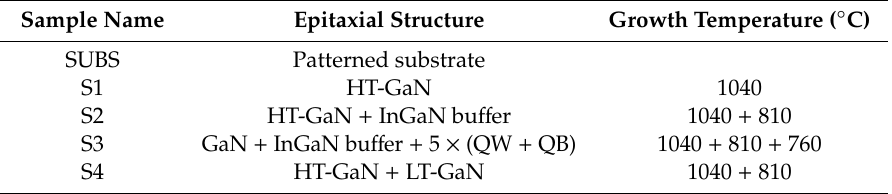
Table 2. Summary of samples used for surface profile characterization. QB: quantum